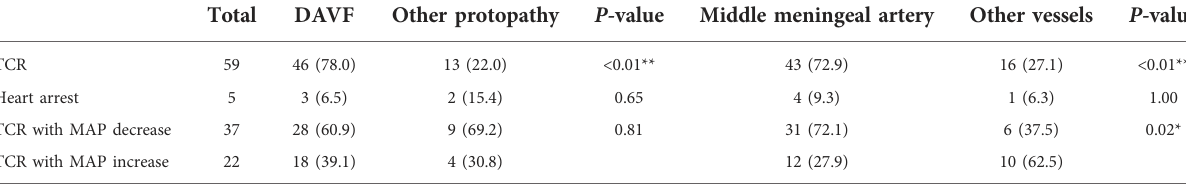
TABLE 3 Description of patients with signi fi cant hemodynamic fl uctuations.